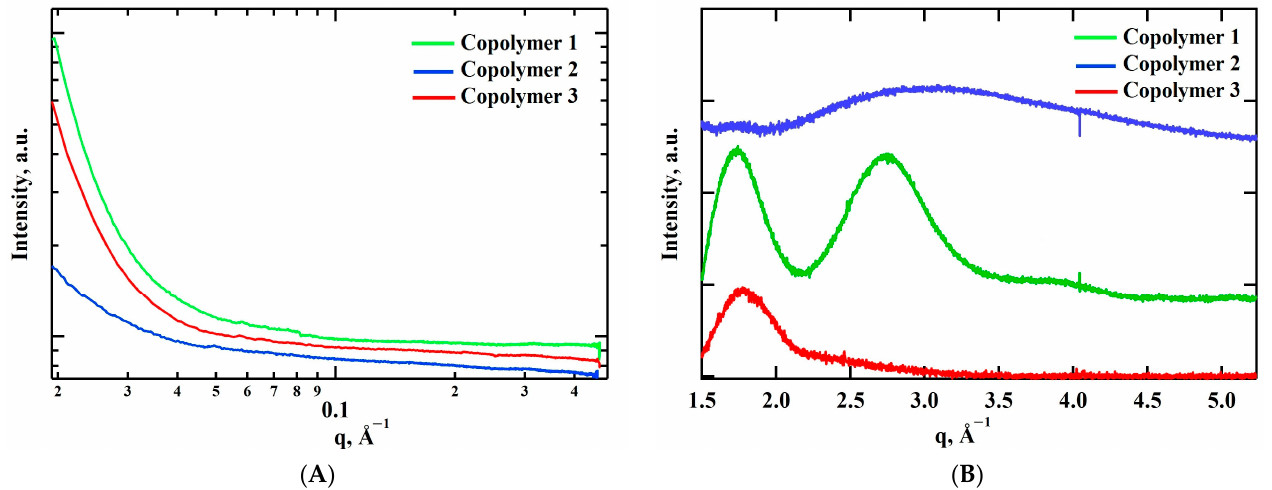
Figure 3. SAXS ( A ) and WAXS ( B ) of copolymers with 1 wt.% CoAcr 2 PhTpy: copolymer 1—AAm/AAc 84.5/14.5; copolymer 2—AAm/AAc = 49.5/49.5; copolymer 3—AAm/AAc = 14.5/84.5.